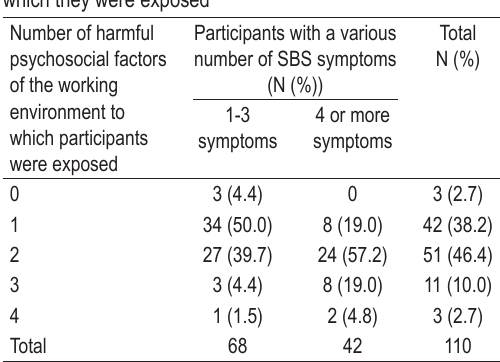
TABLE 3. Participants with a various number of symptoms of sick building syndrome according to the number of harmful psychosocial factors of the working environment to which they were exposed Number of harmful psychosocial factors of the working environment to which participants were